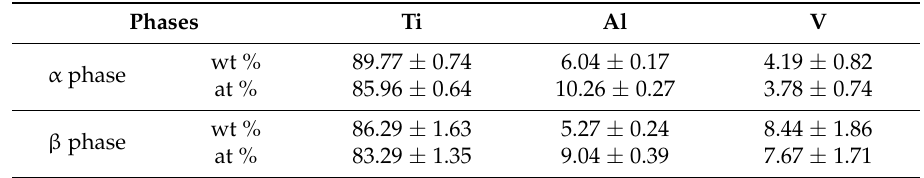
Table 3. The average element concentration of α and β phases, including statistical standard deviation (based on ten measurements).